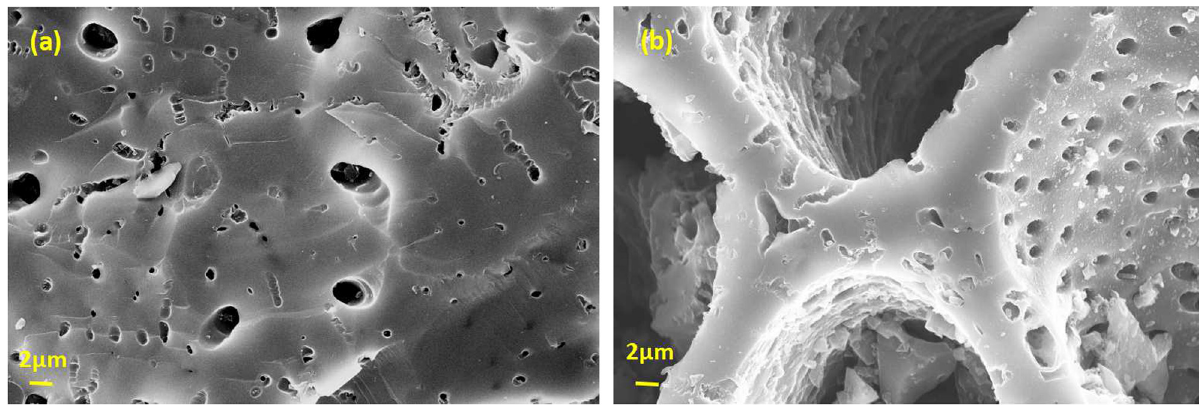
Figure 2: The SEM images of ( a ) CAC and ( b ) MCAC.